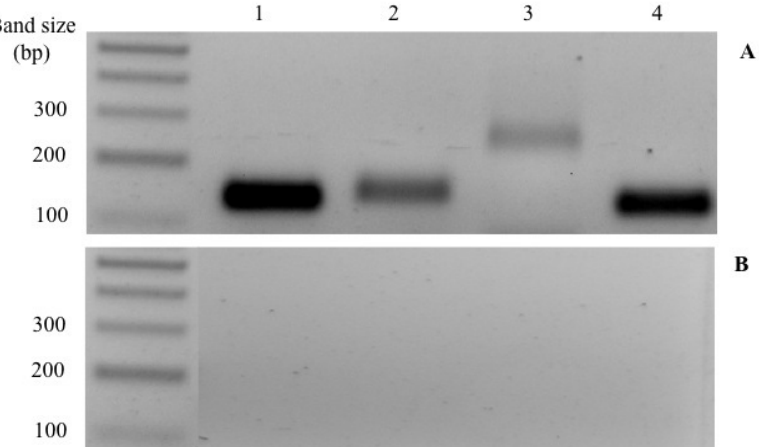
Figure 1. Specific RT-PCR was used to amplify seabream pth1r (2), pth3r (3), and casr (4) in mRNA extracts from the corpuscles of Stannius ( A ). 18s (1) was used as a reference to control the quantity and quality of cDNA included in PCR reactions. The size of the bands is 139 bp for 18s , 142 bp for pth1r , 250 bp for pth3r, and 131 bp for casr . A negative control of every reaction is displayed in ( B ).